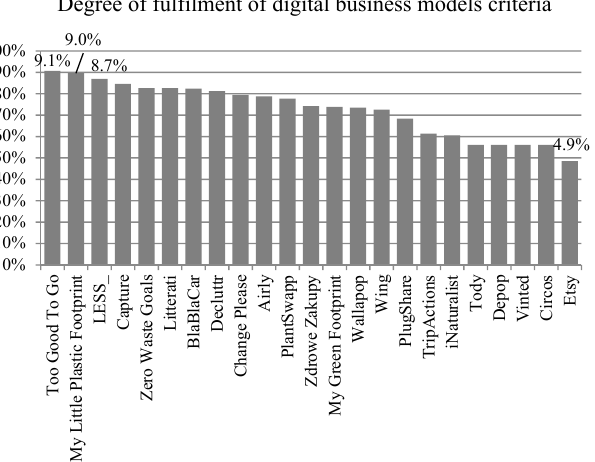
Figure 3. The total values are the result of the research by means of the AHP method (own